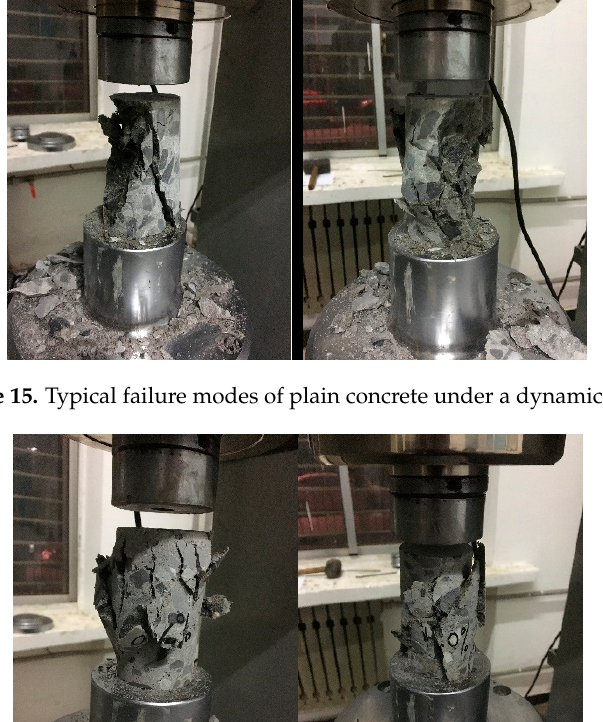
Figure 14. Typical stress–strain curve under different strain rates for ( a ) C30PVA0, ( b ) C40PVA0, ( c ) C30PVA0.2, ( d ) C40PVA0.2, ( e ) C30PVA0.4, ( f ) C40PVA0.4, ( f ) C40PVA0.4, and ( h ) C40PVA0.6.